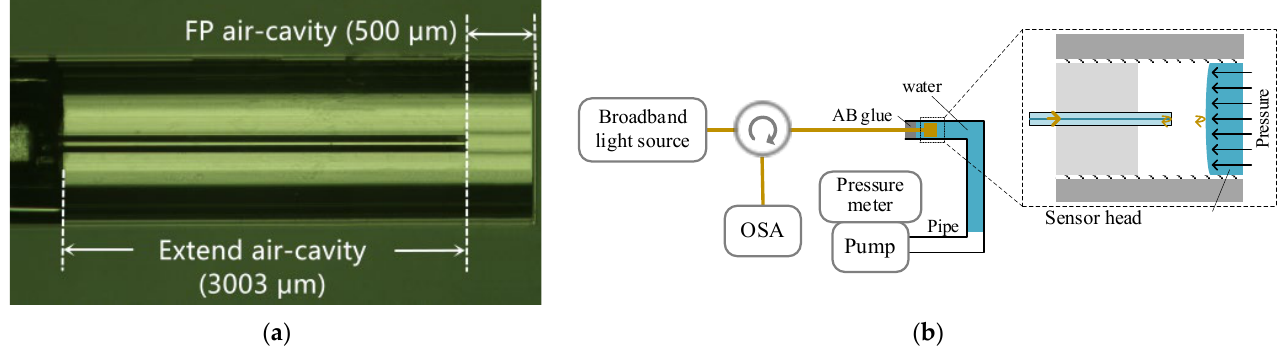
Figure 2. ( a ) Micrograph of sample-4 in air. ( b ) Experimental set-up to test the sensitivity of the pressure sensor head with EAC.